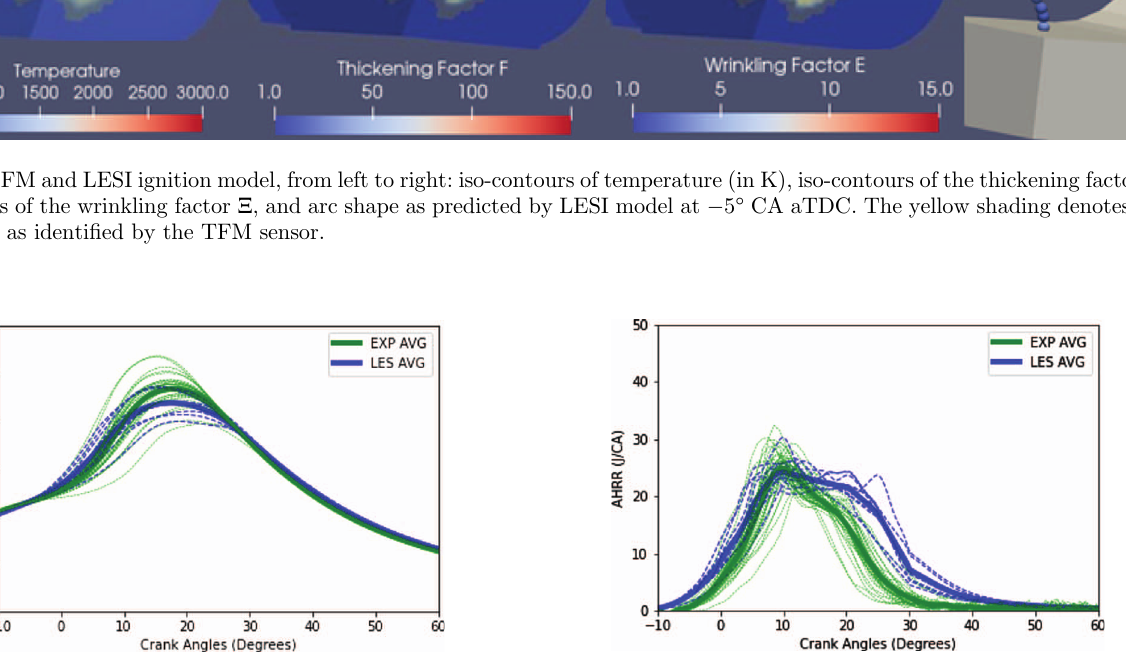
Fig. 14. g -equation model and LESI ignition model: peak in- cylinder pressure for LES (blue) and experiments (green). Individual cycles are denoted by the dashed lines and the ensemble average is denoted by bold lines.